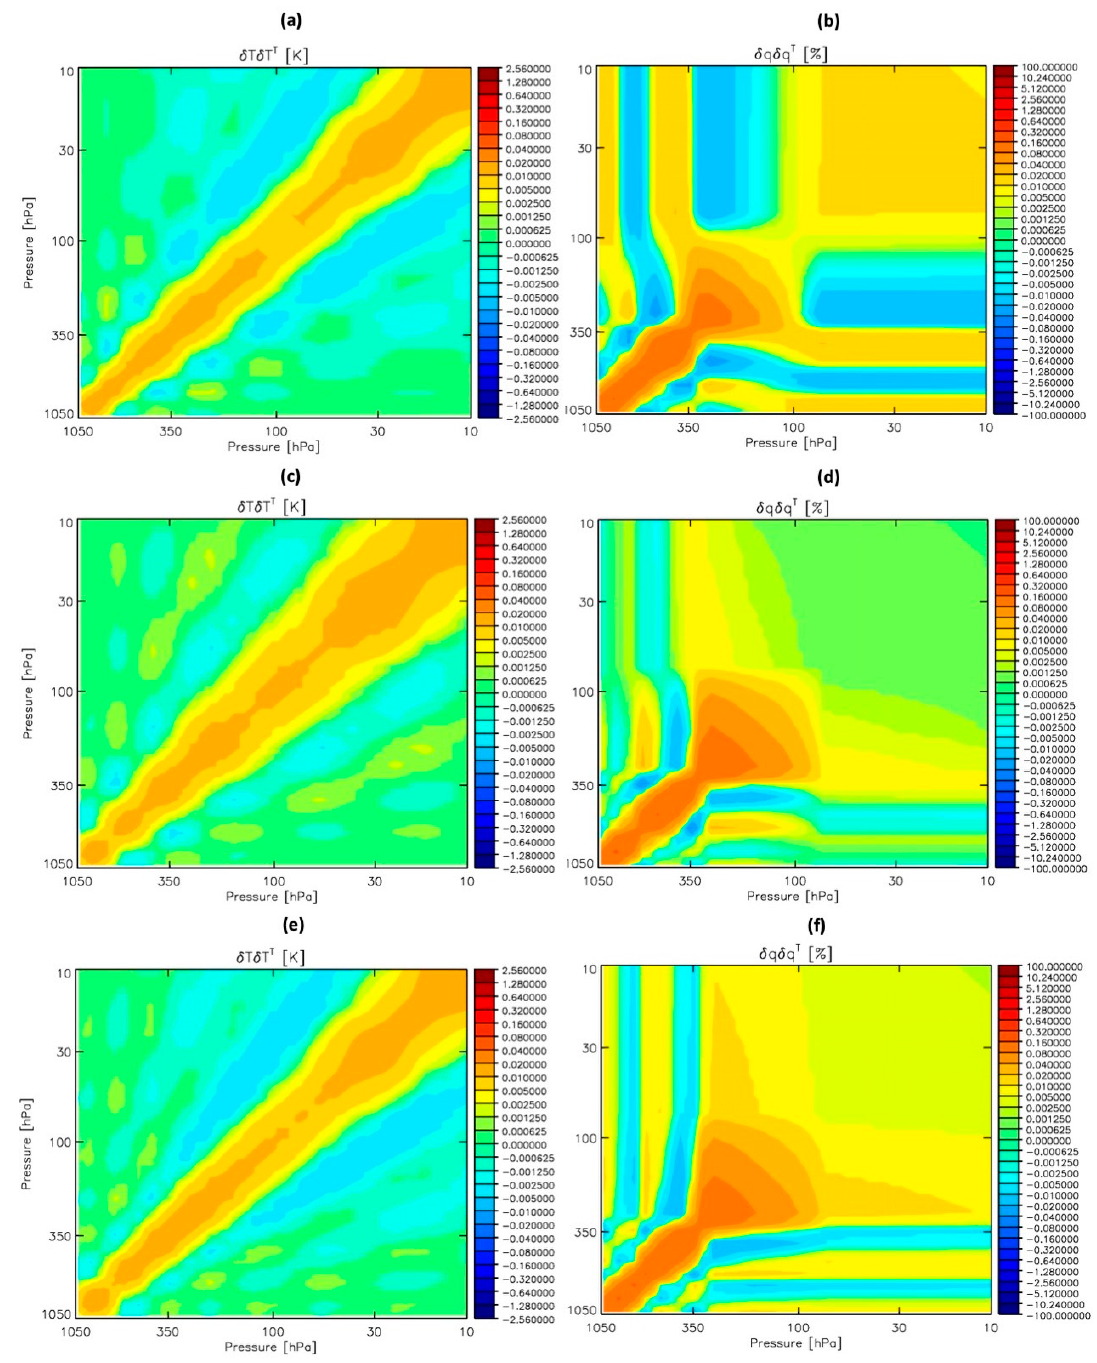
Figure 8. CLIMCAPS spectral error covariance matrix of (left column) temperature and (right column) water vapor for three different datums at latitude/longitude locations ( a,b ) [ − 44.33, 7.6], ( c,d ) [ − 43,31, 5.1], and ( e,f ) [ − 40.81, 17.7]. The color scale is highly non-linear to highlight the extremes, as well as the subtle off-diagonal structures.